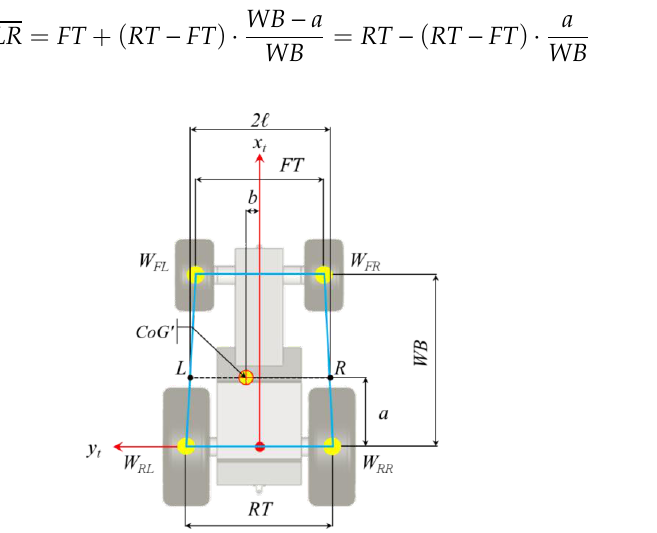
Figure 5. Farm tractor with different widths at the front and rear tracks: in this case L and R are the extremal points and 2 ℓ the length (i.e., the vehicle width) of the segment perpendicular to the longitudinal axis in correspondence of the projection of the center of gravity (CoG′).